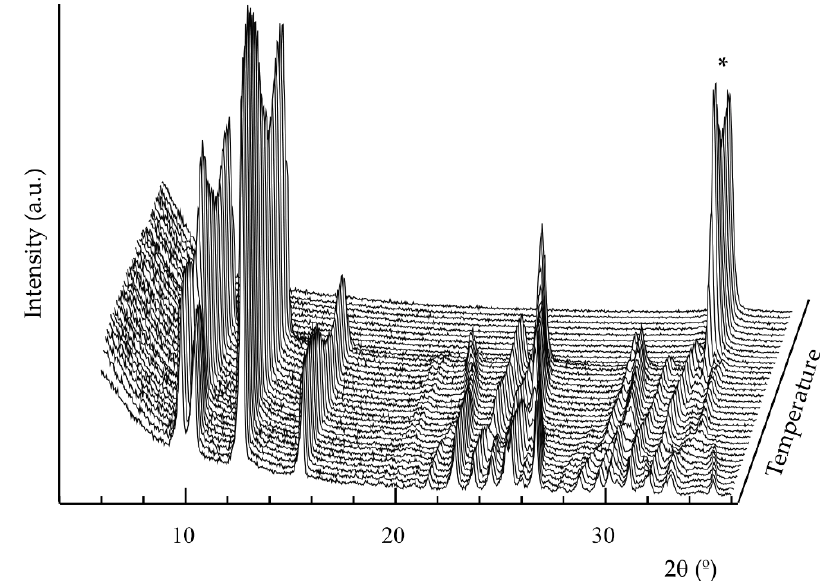
Figure 6. Temperature dependent X-ray diffraction analysis of 2 . The temperature variation between each diffractogram is 15 °C. * (111) peak of CdO.